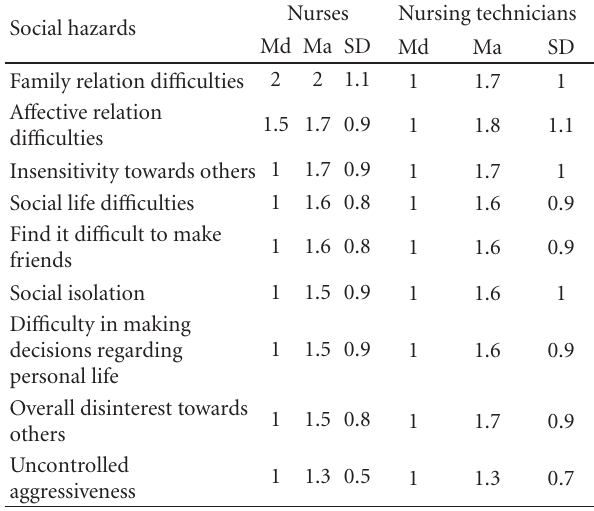
Table 3: Medians, means, and standard deviations of psychological damage among nurses and nursing technicians, Bras´ılia, 2007.